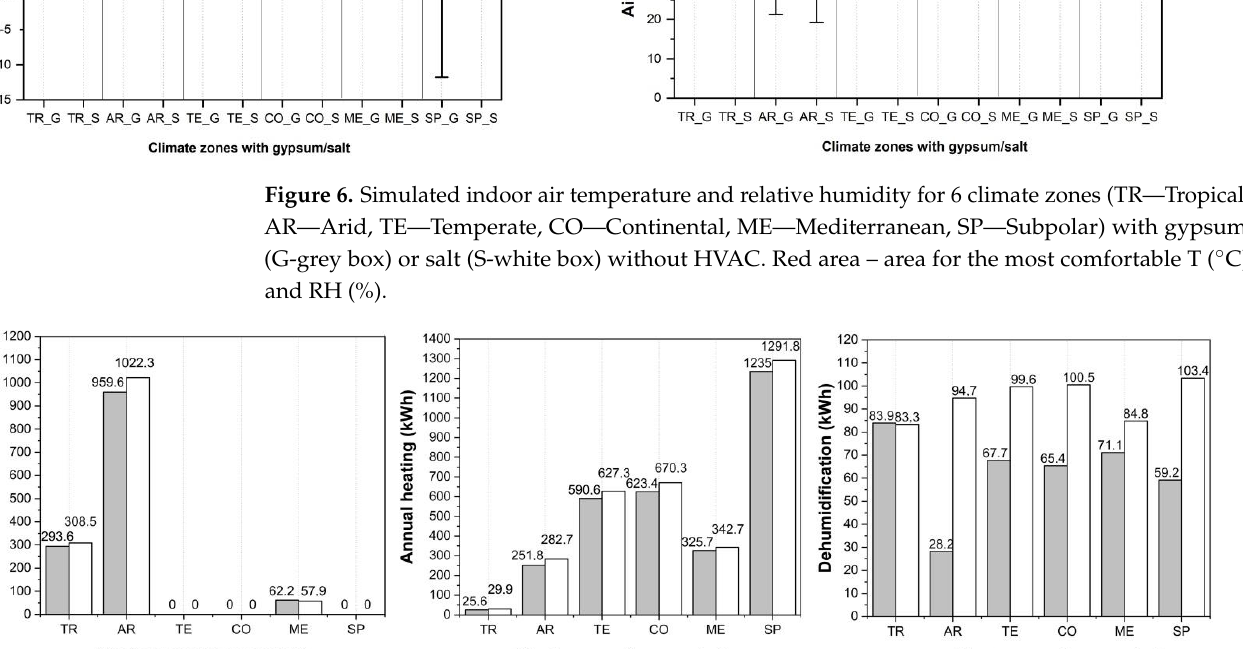
Figure 6. Simulated indoor air temperature and relative humidity for 6 climate zones (TR—Tropical, AR—Arid, TE—Temperate, CO—Continental, ME—Mediterranean, SP—Subpolar) with gypsum (G-grey box) or salt (S-white box) without HVAC. Red area – area for the most com- fortable T (°C) and RH (%)